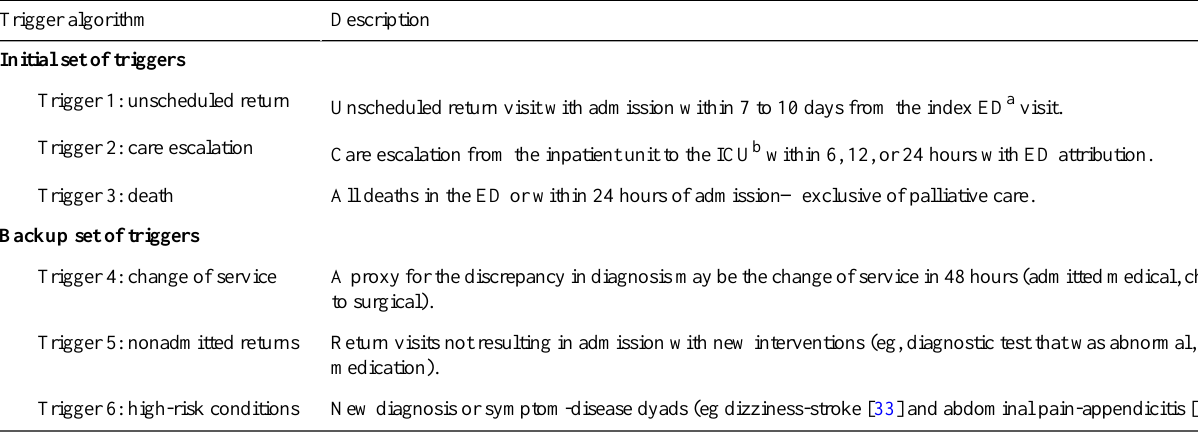
Table 1. Proposed electronic trigger algorithms for identifying diagnostic errors. DescriptionTrigger